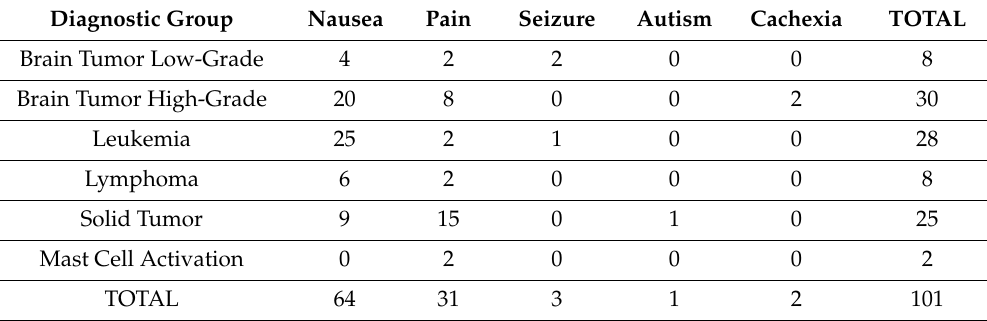
Table 2. Primary reason for medical cannabis certification by diagnostic group.